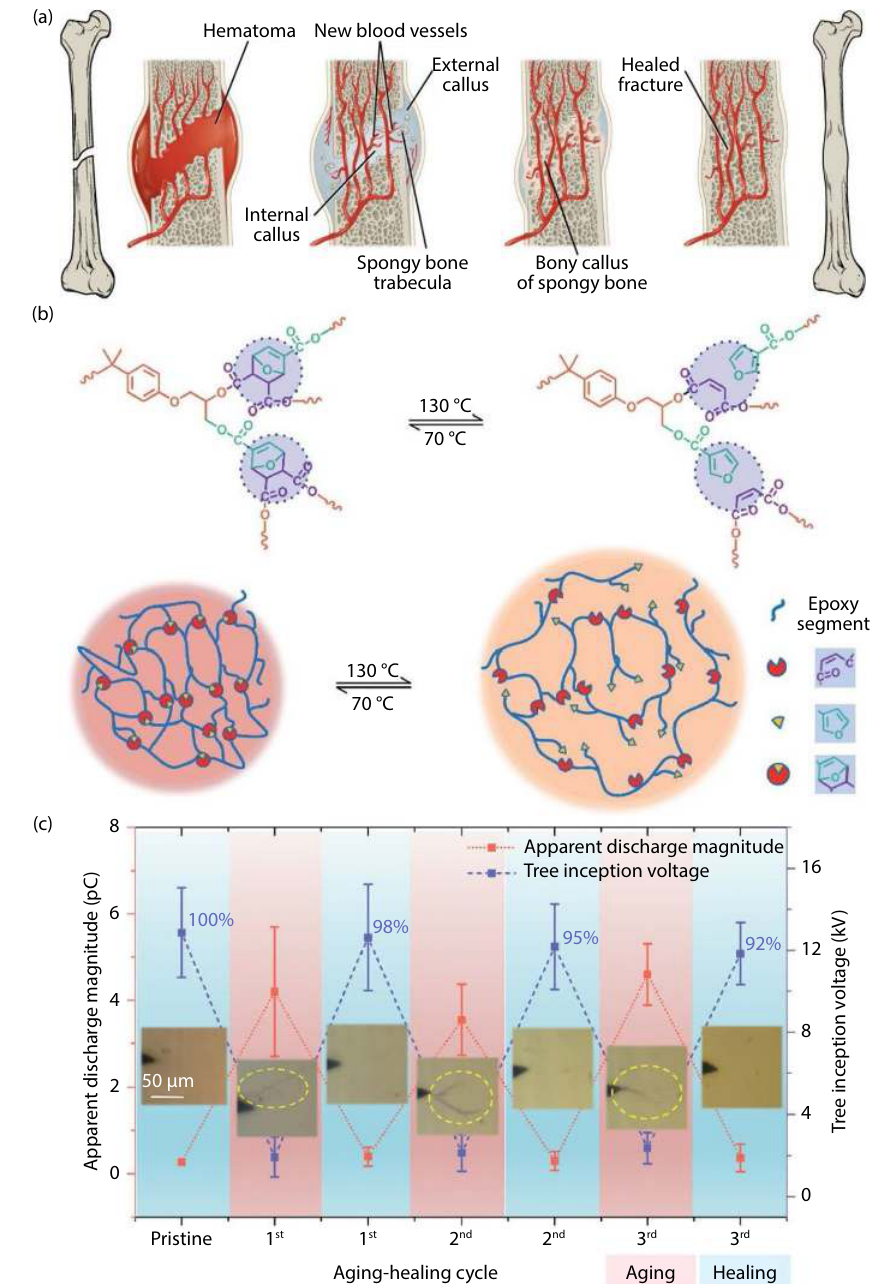
Fig. 20 Inspiration and mechanisms of self-healing by reversible crosslinking networks. ( a ) The healing process of a bone fracture. Spongy bone is first formed at the fracture, and eventually replaced by compact bone (reprinted with permission from ref. [244], © 2021 Rice University). ( b ) Schematic of partially reversible cross- linking network. The polymer network may undergo the conversion between fully crosslinked state and partially crosslinked state under different temperatures (re- printed with permission from ref. [56], © 2021 The Royal Society of Chemistry). ( c ) Insulating properties (apparent partial discharge magnitude and tree inception voltage) and optical images of partially reversible crosslinking epoxy in aging-healing cycles (reprinted with permission from ref. [56], © 2021 The Royal Society of